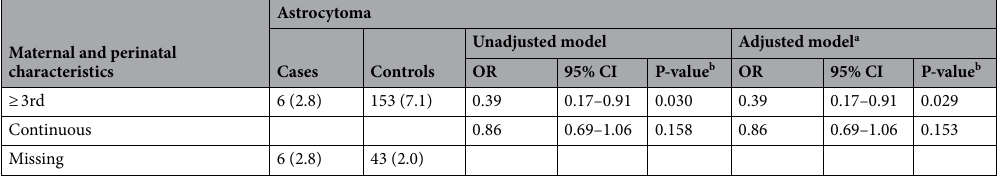
Table 3. Significant associations between maternal and perinatal factors and risk of pediatric astrocytoma, ependymoma, and medulloblastoma. a Adjusted for birth year, sex, maternal race/ethnicity, and maternal